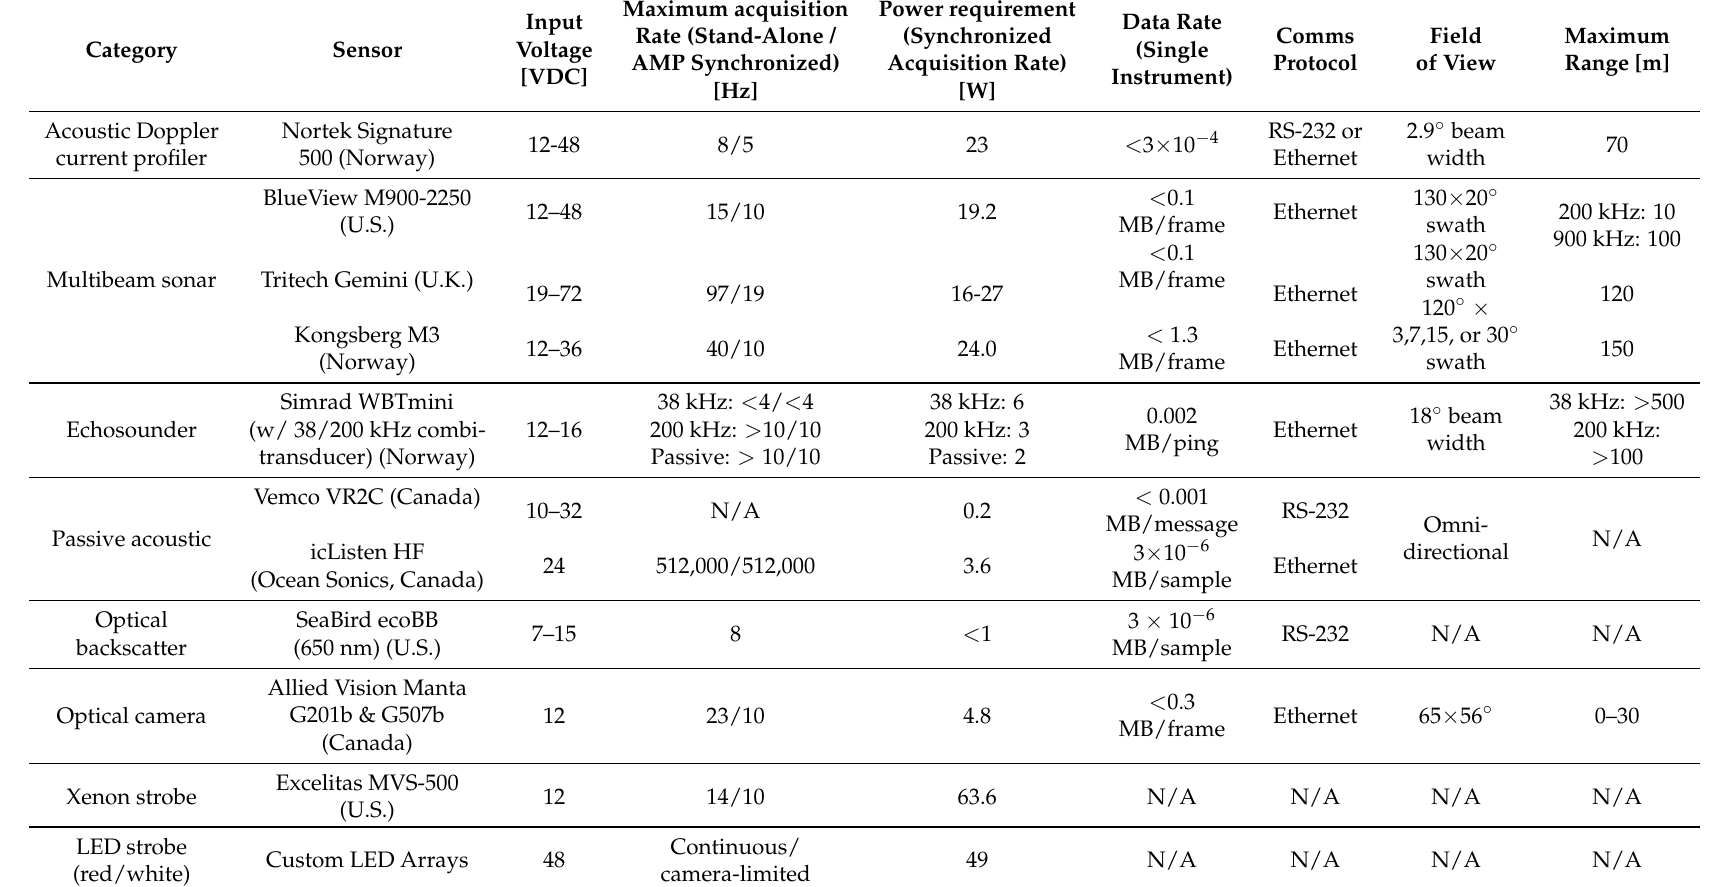
Table 1. AMP sensors. For some sensors, data rates depend on settings, as summarized in Table